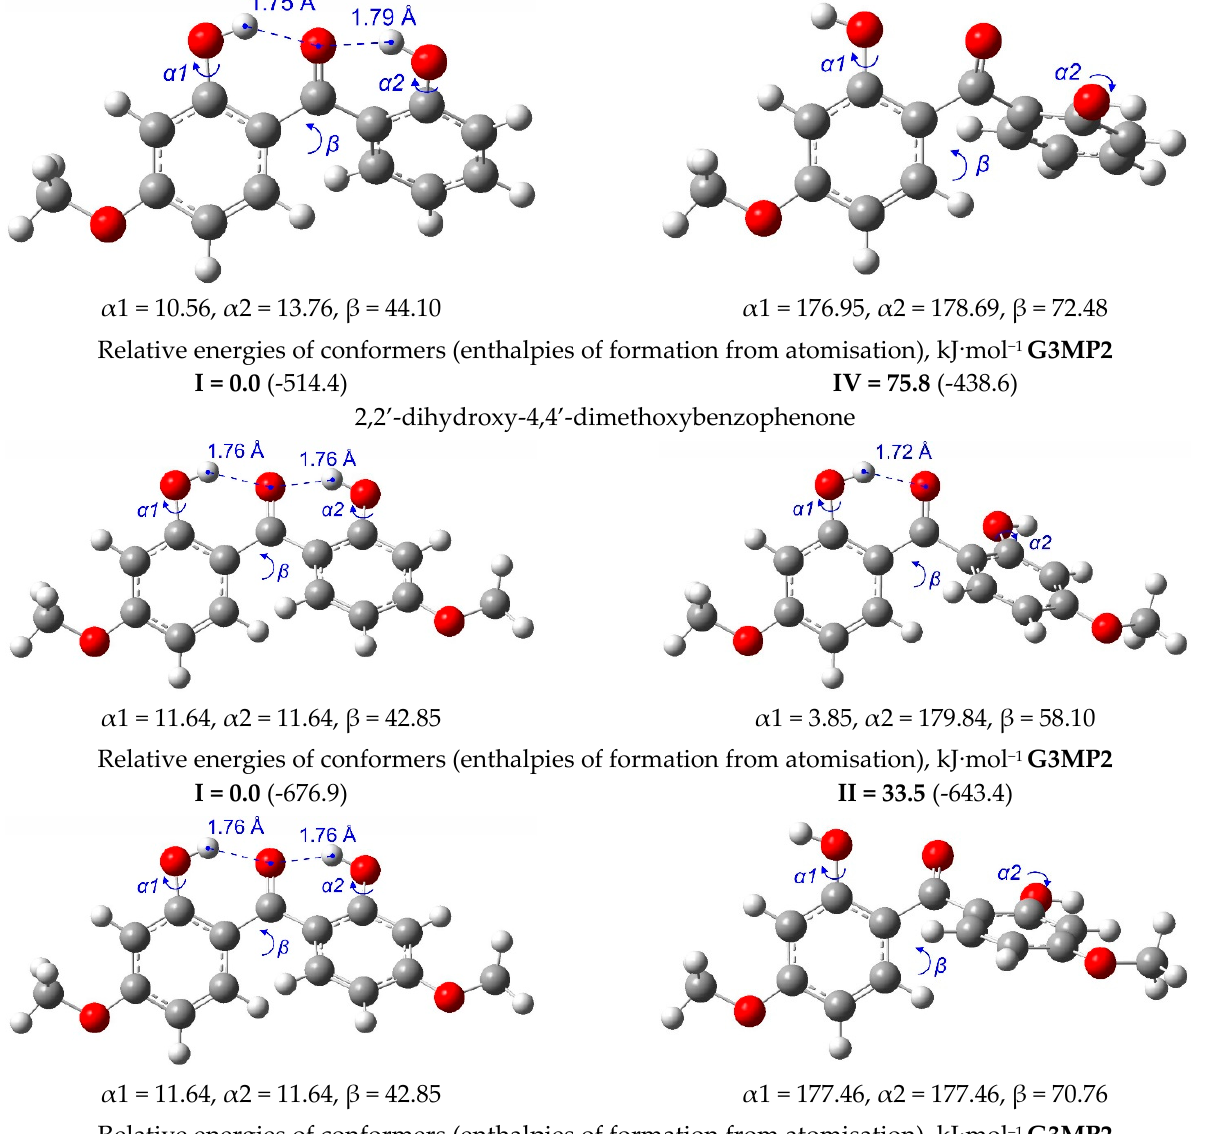
Figure 3. The stable conformers of 2 ‐ hydroxy ‐ substituted benzophenones.